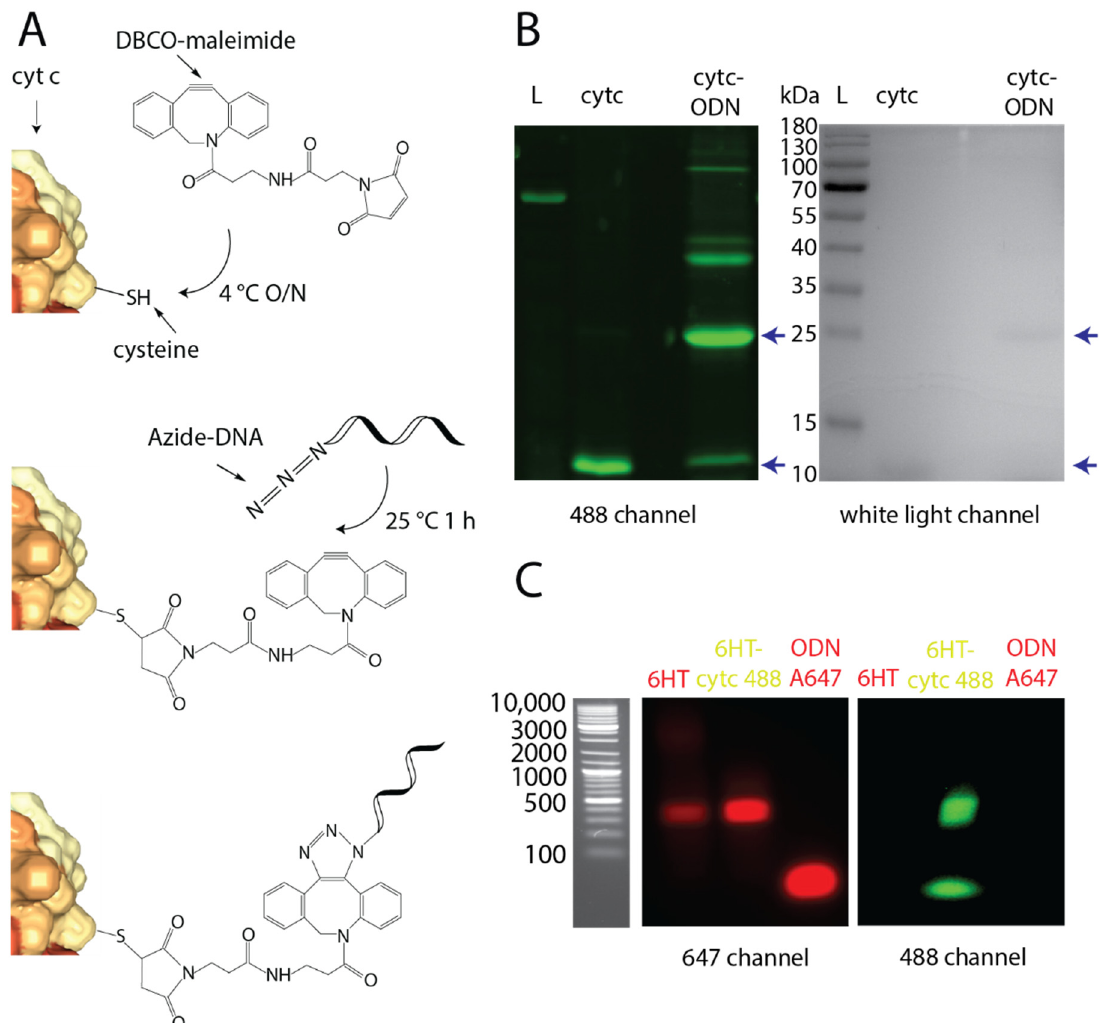
Figure 2. Conjugation of ssDNA to cytochrome c and gel characterization of adducts. ( A ) Stepwise conjugation of azide- modified ssDNA to cytochrome c using a DBCO-maleimide based click reaction. ( B ) SDS-PAGE analysis of DNA-protein conjugates. Cytochrome c and ssDNA-conjugated cytochrome c were stained with the fluorescent No-Stain labeling reagent, visualized in both the 488 nm and white-light channels and highlighted with arrows. ( C ) Agarose gel analysis of DNA nanotube assembly after mixing and annealing of Atto488-labelled cytochrome c-conjugated ssDNA with unconjugated tiles. Gels were visualized in both the 647 nm and 488 nm channels to distinguish between the 6-helix DNA nanotubes (6HT) with or without cytochrome c conjugation. L, molecular weight marker.